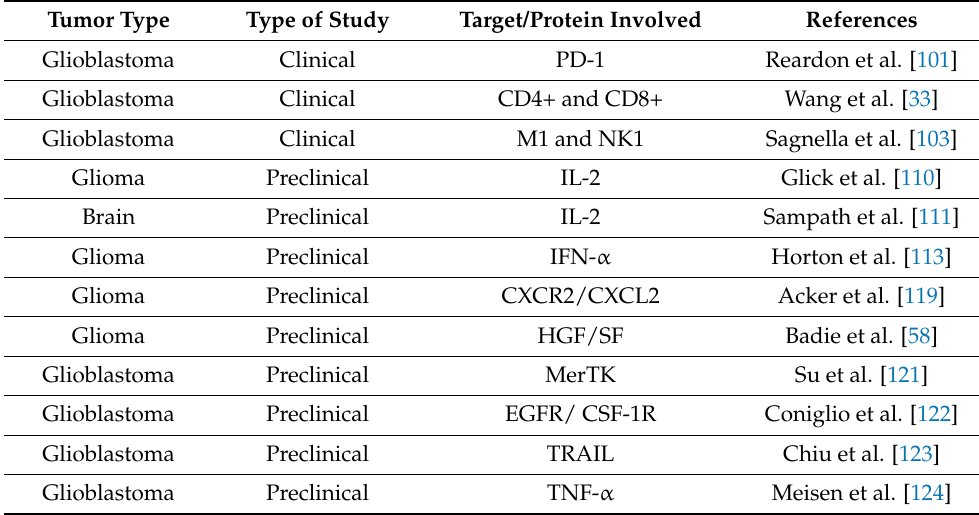
Table 1. The table summarizes the scientific paper showing the type of tumor that was investigated and the target proteins